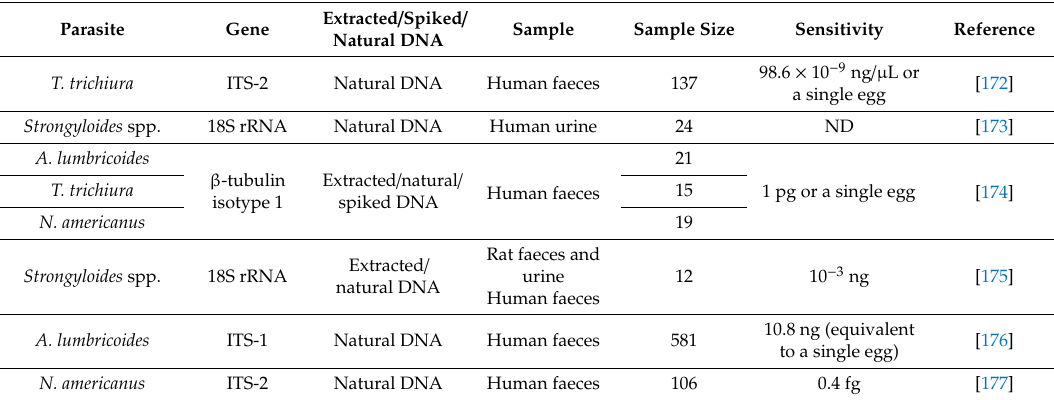
Table 17. Publications found in the US National Library of Medicine National Institutes of Health (NCBI-PubMed) reporting the standardisation of the LAMP technique as a useful tool for diagnosing soil-transmitted helminthiases (intestinal worms) in the definitive